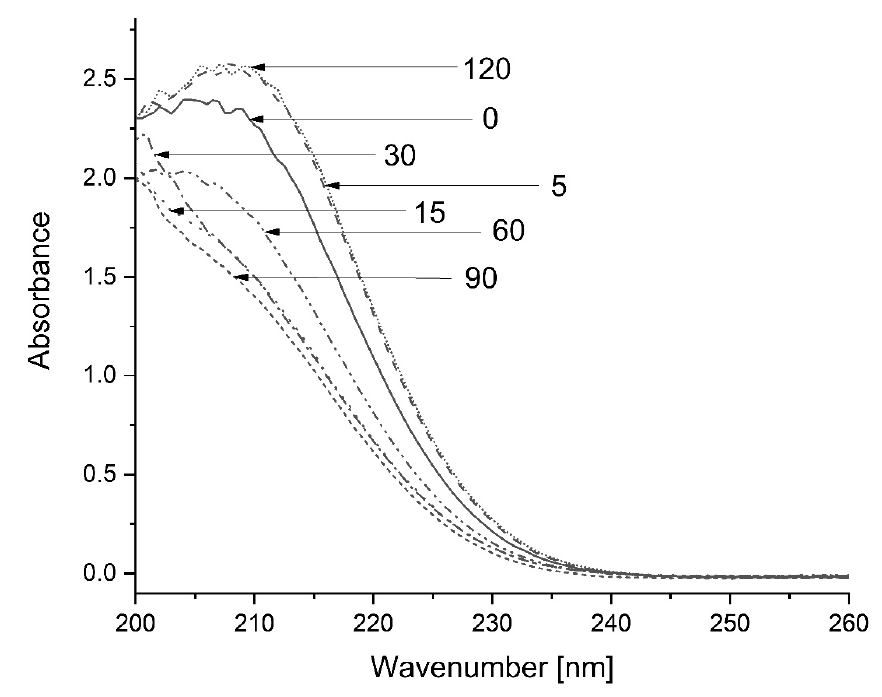
Figure 1. Ultraviolet/visible (UV/VIS) absorption spectra of water treated with glow plasma of low frequency (GP) for 0 to 120 frequency (GP) for 0 to 120 min.